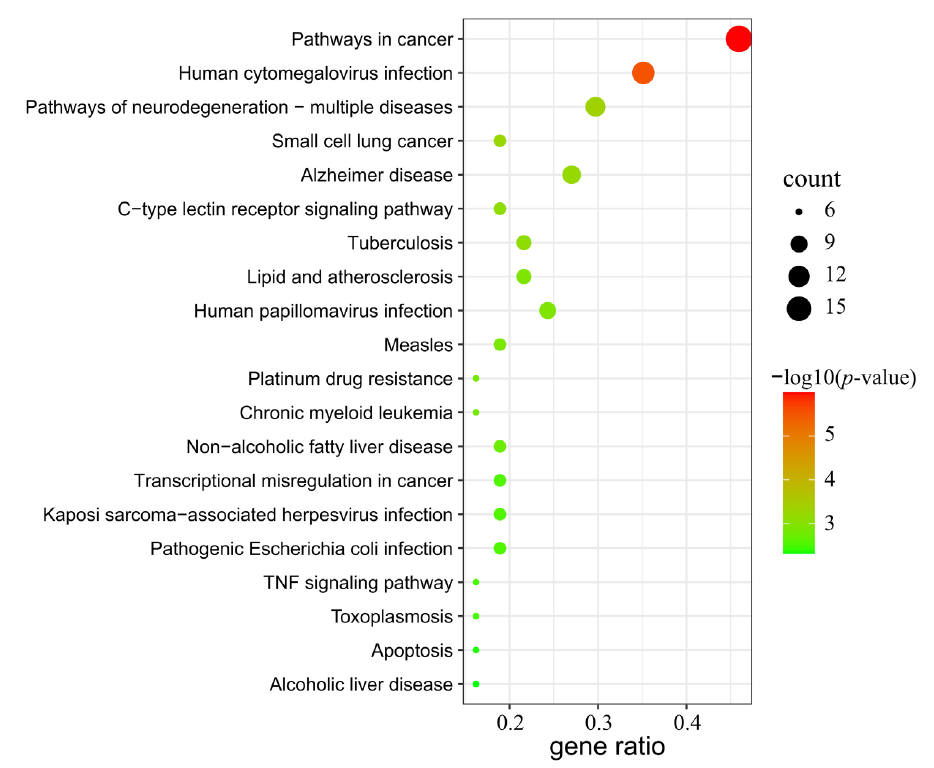
Figure 6. The top 20 significantly enriched pathways of the candidate targets of AR in the treatment of GU. The y-axis represents the KEGG pathway. The x-axis represents the ratio of genes enriched in the pathway. The size of bubbles indicates the number of targets, and the color indicates the p value.